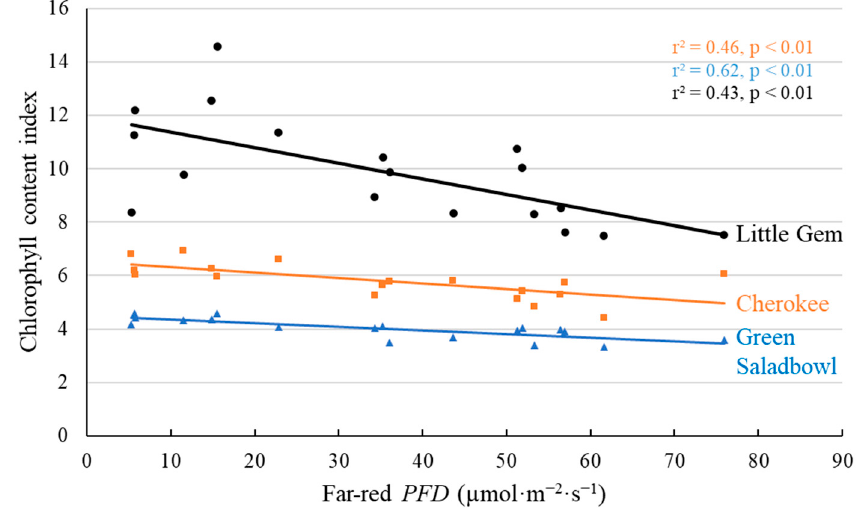
Figure 6. With a background of 204 µ mol · m − 2 · s − 1 white LED light, supplemental far-red photons linearly decreased chlorophyll content index at 16 days after the start of far-red light treatment for ‘Cherokee’, ‘Green Saladbowl’ and ‘Little Gem’ lettuce. The r 2 and p values for regression of each cultivar are shown with the respective color.